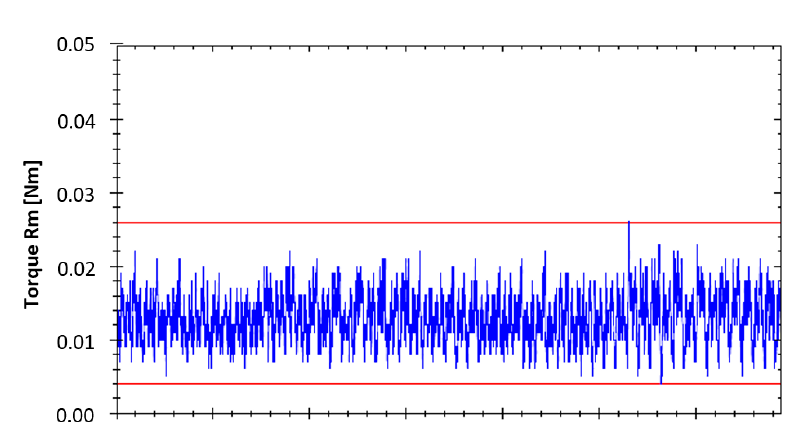
Figure 19. Course of the hysteresis curve BR TS 050-63, s/n.1911.